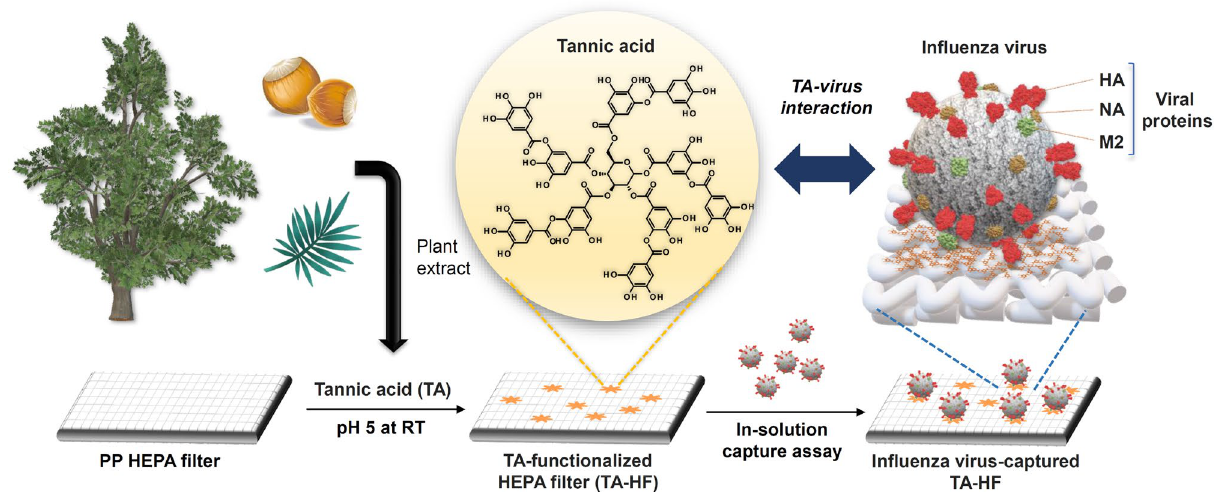
Figure 1. Preparation of TA-HF for influenza virus capture. Schematic illustration of TA-HF preparation and influenza virus capture based on interaction of TA with viral proteins ( HA hemagglutinin, NA neuraminidase, M2 matrix-2). TA tannic acid, HF high-efficiency particulate air filter.